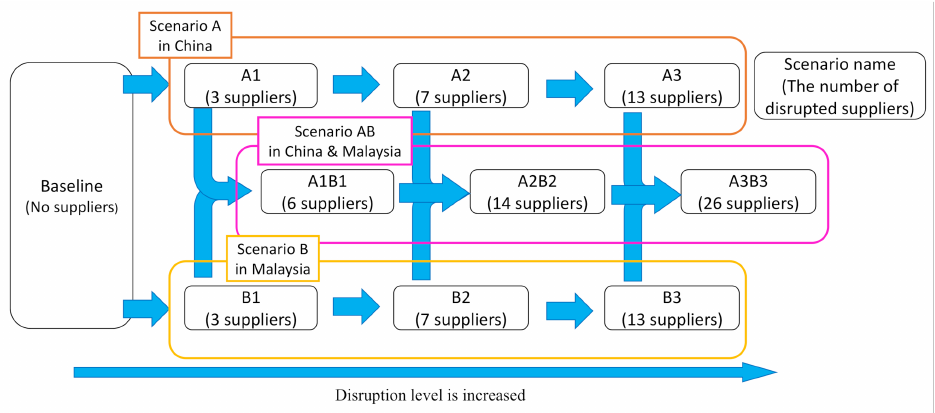
Figure 5. The sequence for